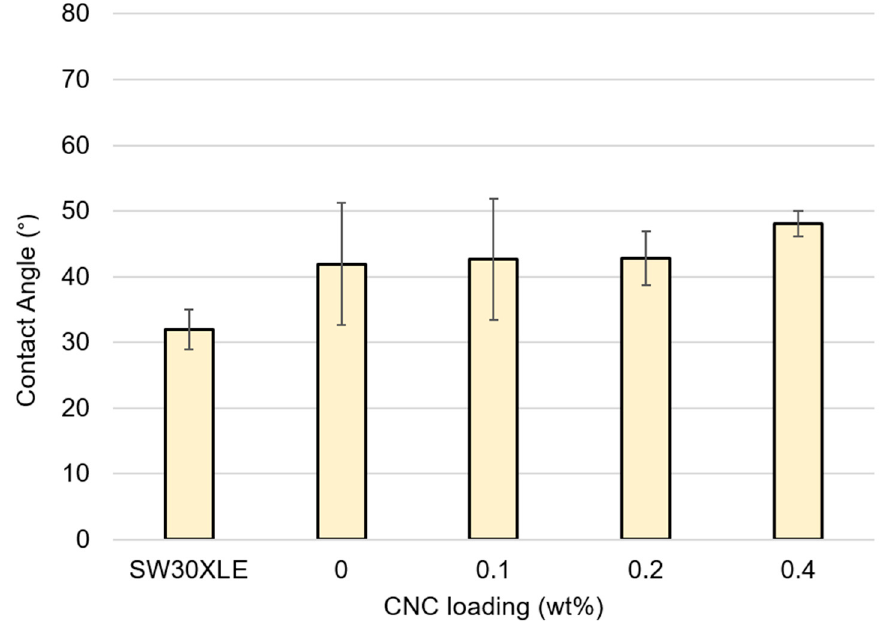
Figure A6. Contact angle measurements for TFN membranes with loading levels of unmodified CNC between 0 and 0.4 wt%. For comparison, measurements from a DOW SW30XLE industrial membrane are included.